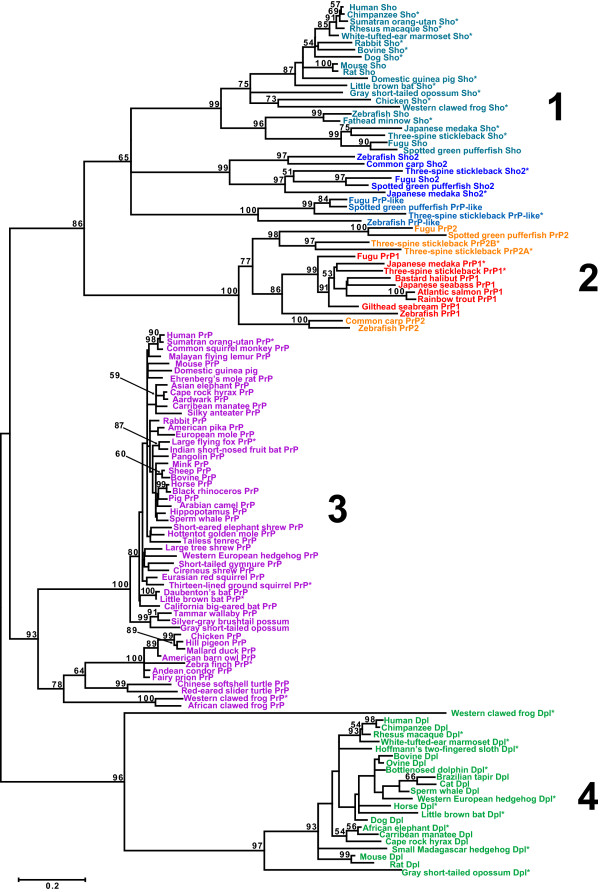
The bootstrap consensus NJ tree for prion genes (122 proteins, 5000 replicates). The bootstrap values >50 are depicted. The horizontal bar shows 0.2 amino acid substitutions per site. 1–4, major clusters.